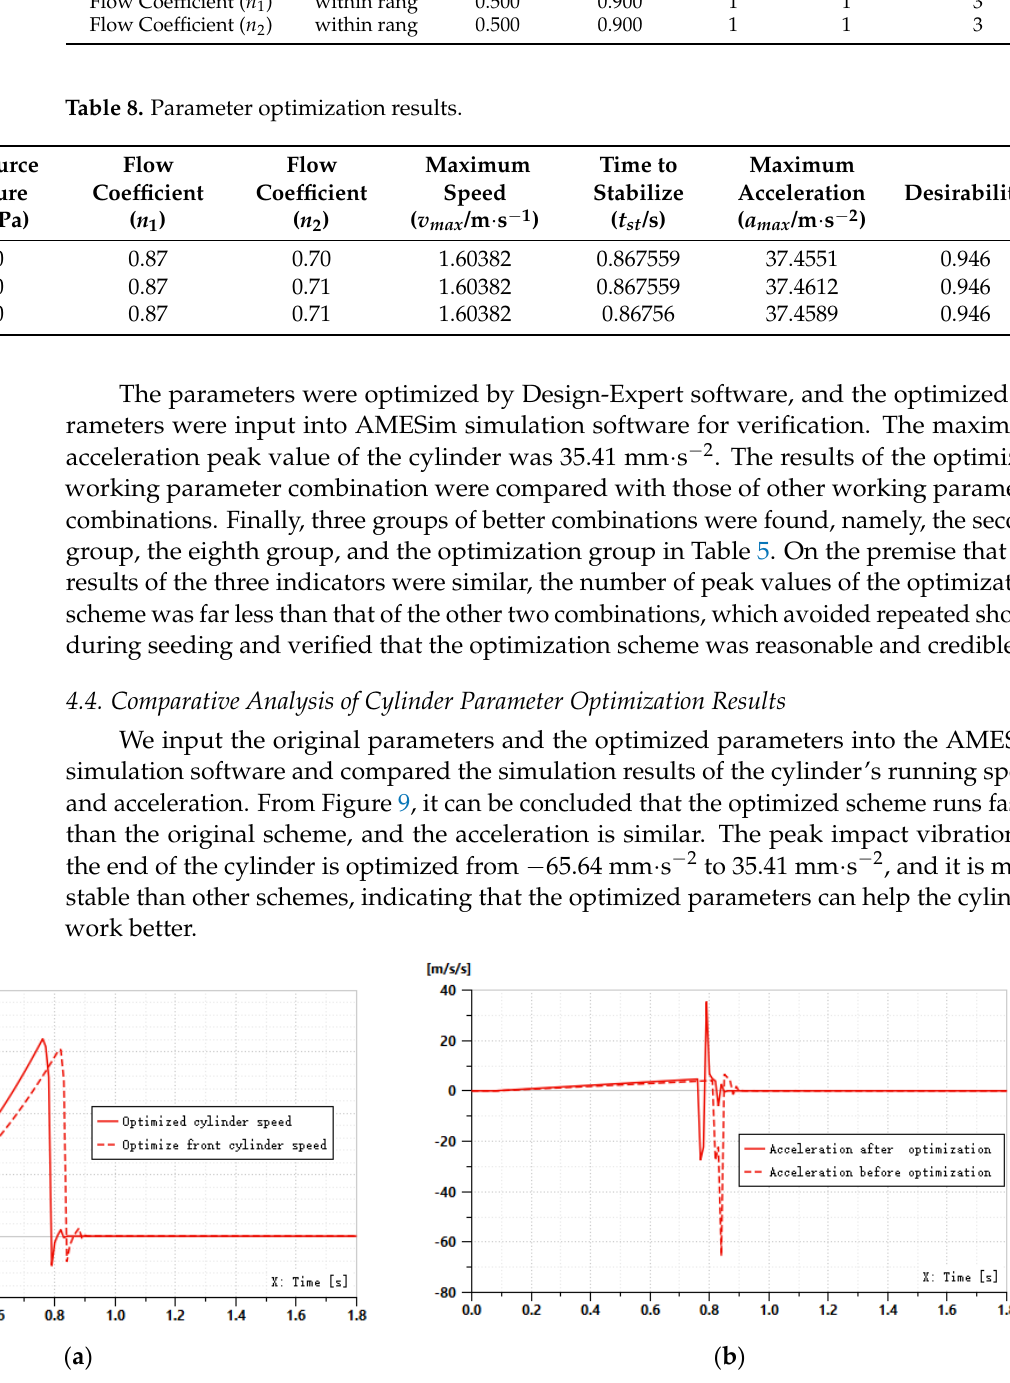
Figure 9. Comparison of response surface optimization results for velocity and acceleration: ( a ) comparison of results before and after optimization of cylinder speed; ( b ) comparison of results before and after optimization of cylinder